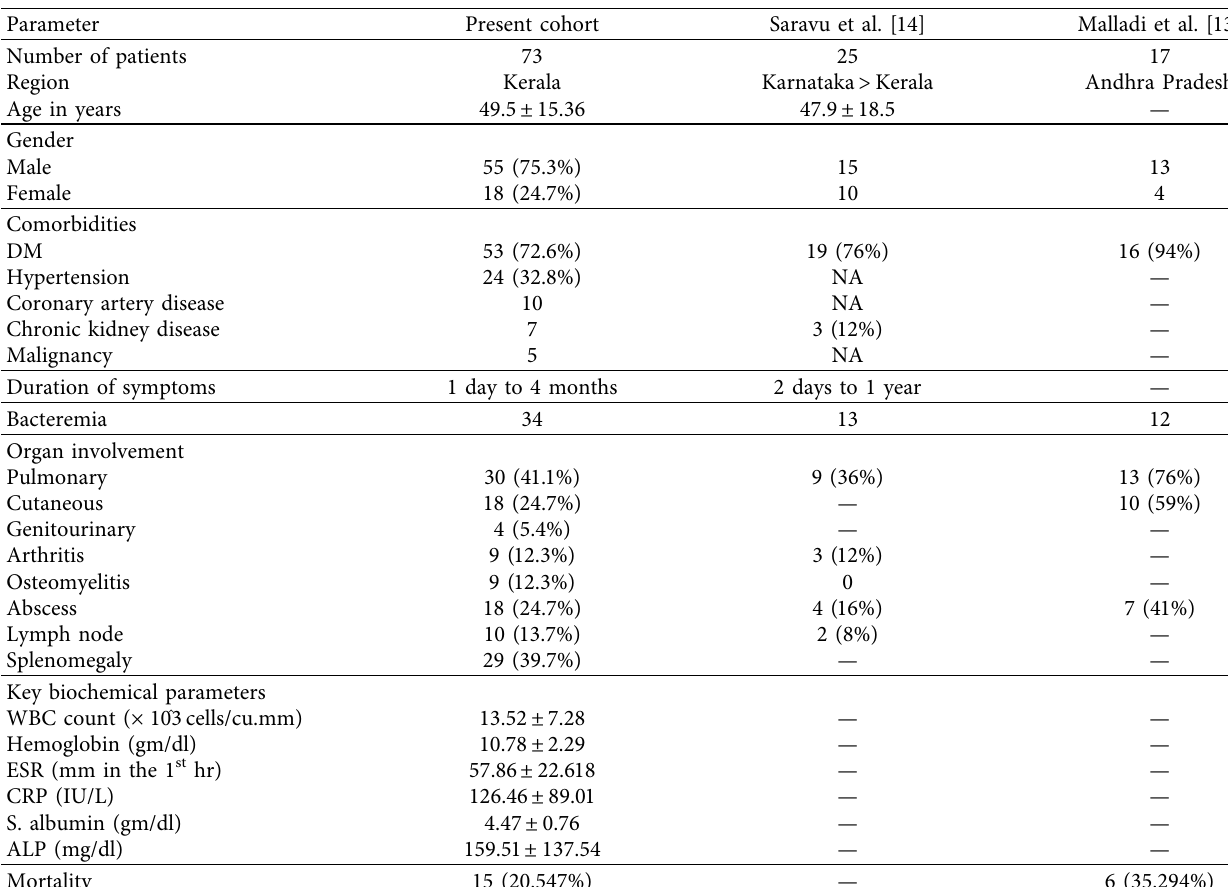
Table 1: Comparison between demographic, clinical, and laboratory findings of the present study against other single-centre South Indian